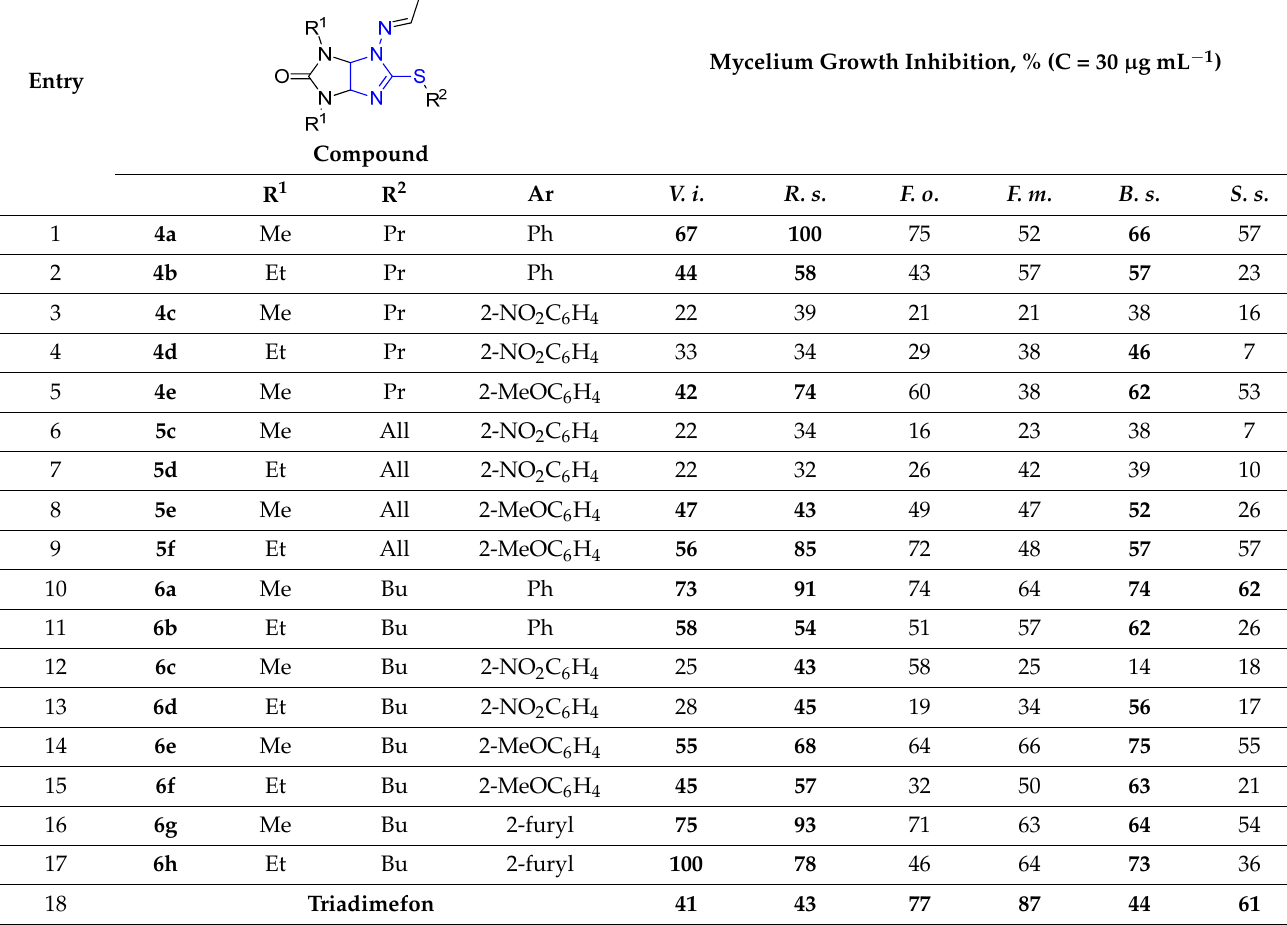
Table 1. In vitro fungicidal activity of compounds 4a–e , 5c–f , and 4a–f against Venturia inaequalis ( V.